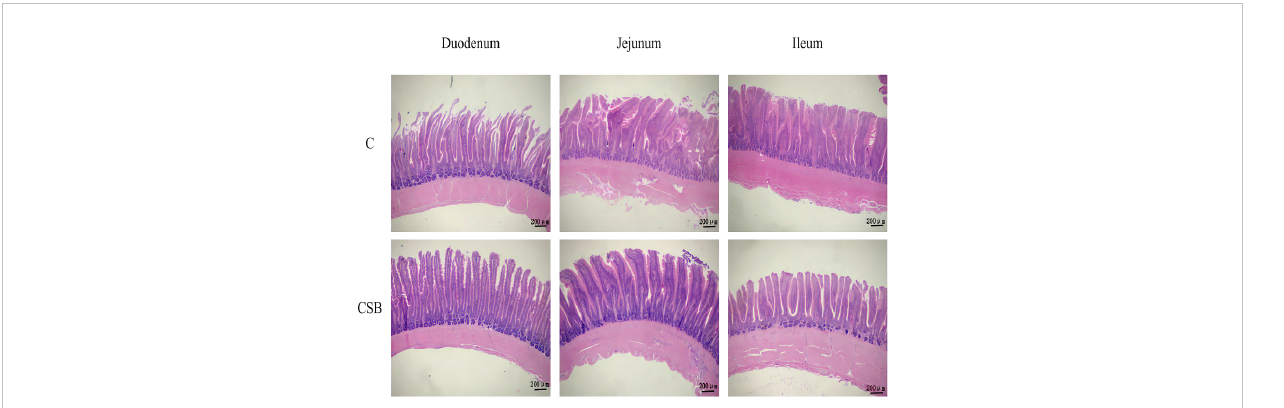
FIGURE 6 Effects of dietary supplementation of coated sodium butyrate (CSB) on the intestinal (duodenal, jejunal, and ileal) morphology of laying ducks. Intestinal sections were stained with hematoxylin and eosin (H&E). group C, Control group, which was fed a basal diet; CSB group, CSB-treated group, which was fed the basal diet supplemented with 250 g/t of CSB.